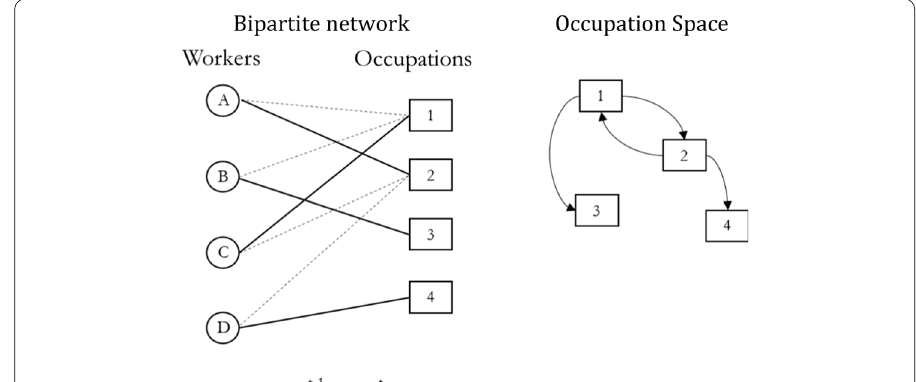
Fig. 1 From panel data to network. Note : Worker A held occupation 1 in t t , generating the directed arrow from node 1 to 2 in the occupation